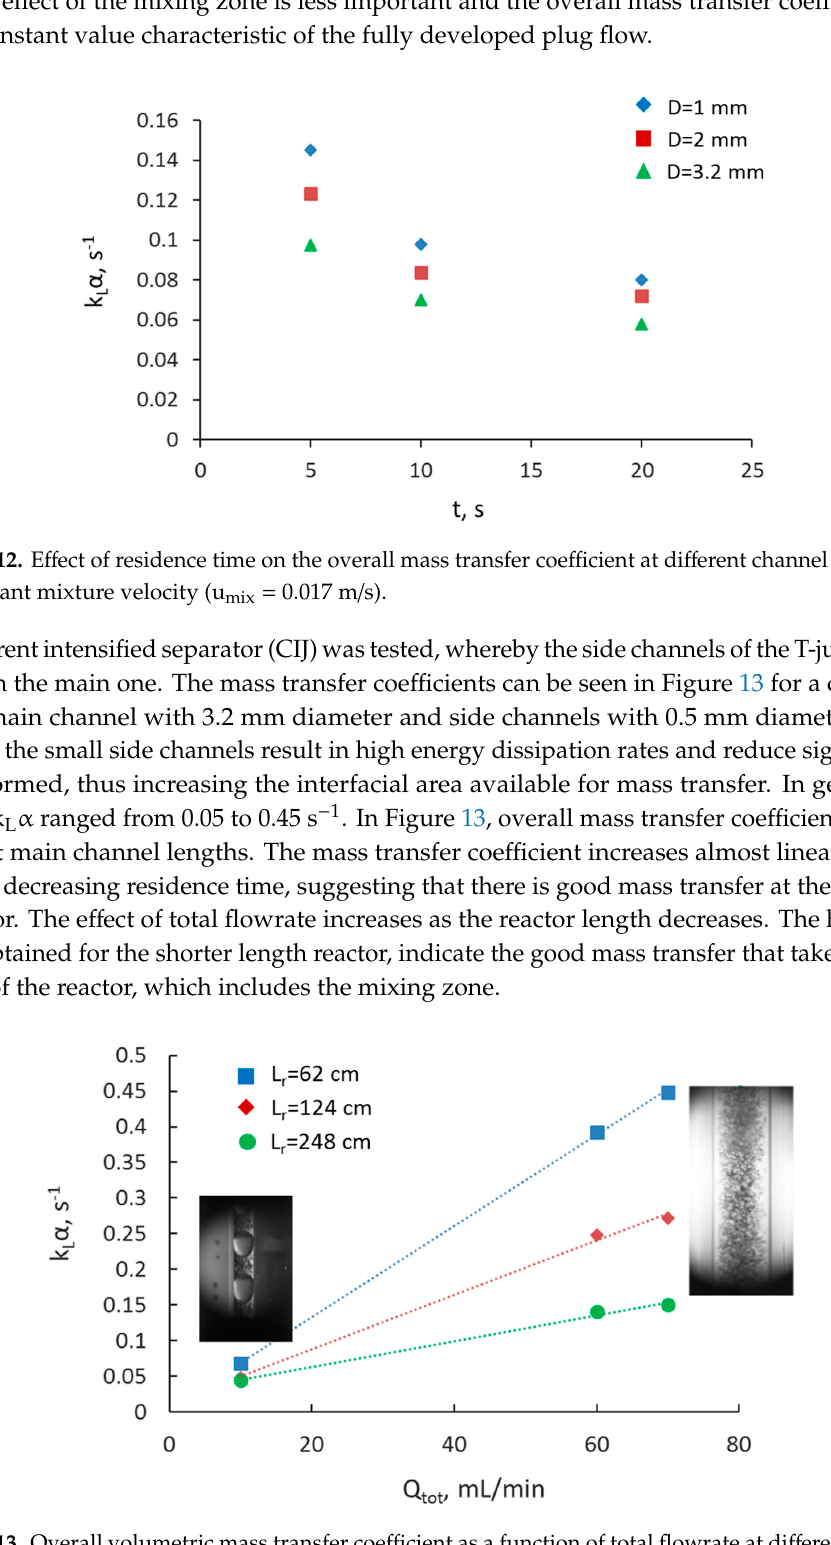
Figure 13. Overall volumetric mass transfer coe ffi cient as a function of total flowrate at di ff erent reactor lengths for the CIJ cell. Photos indicate the flow pattern obtained at low and high total flow